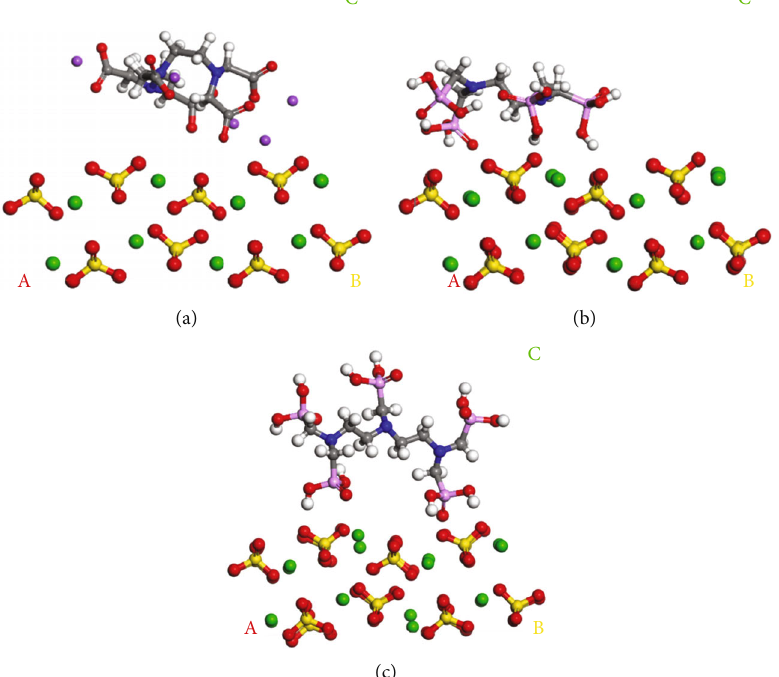
Figure 6: (001) Surface of barium sulfate is interacting with (a